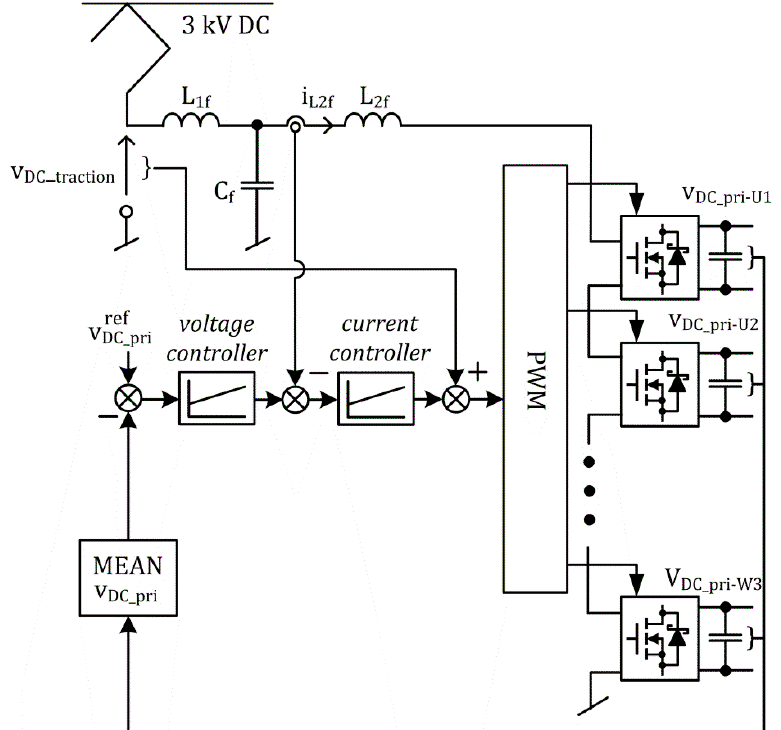
Figure 12. The overall control scheme for the DC PETT input stage.